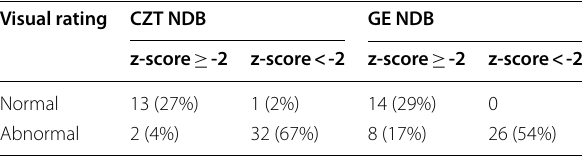
Table 3 Crosstab comparing the visual rating in the test group to putaminal z-scores with the CZT NDB and GE